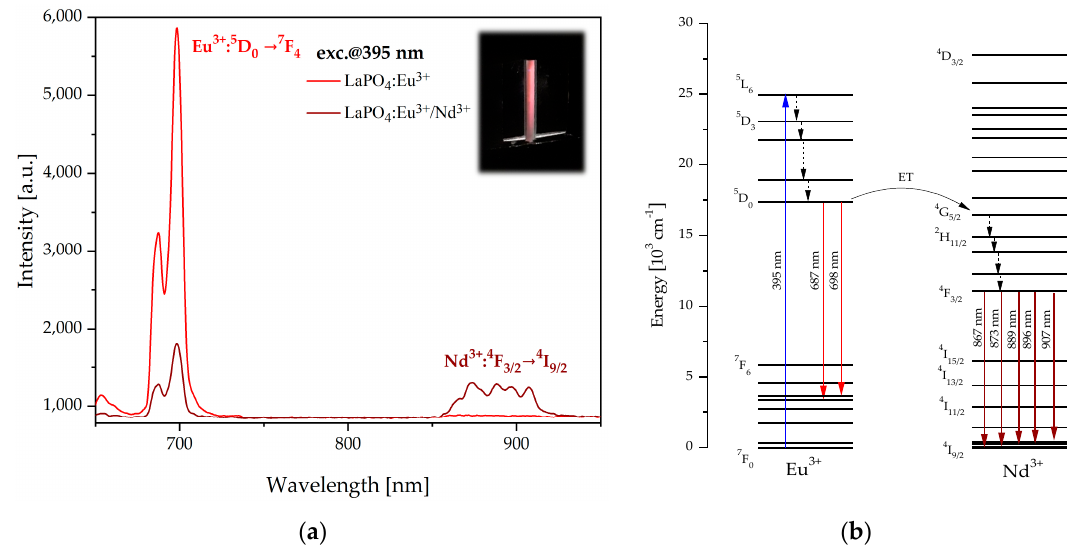
Figure 4. Luminescence spectra of LaPO 4 :Eu 3+ and LaPO 4 :Eu 3+ /Nd 3+ with inset of fluorescence sample LaPO 4 :Eu 3+ ( λ exc = 395 nm) ( a ) and simplified energy level diagram of Eu 3+ and Nd 3+ ( b ) illustrates the possible mechanism of energy transfer and radiative transitions in first biological window.